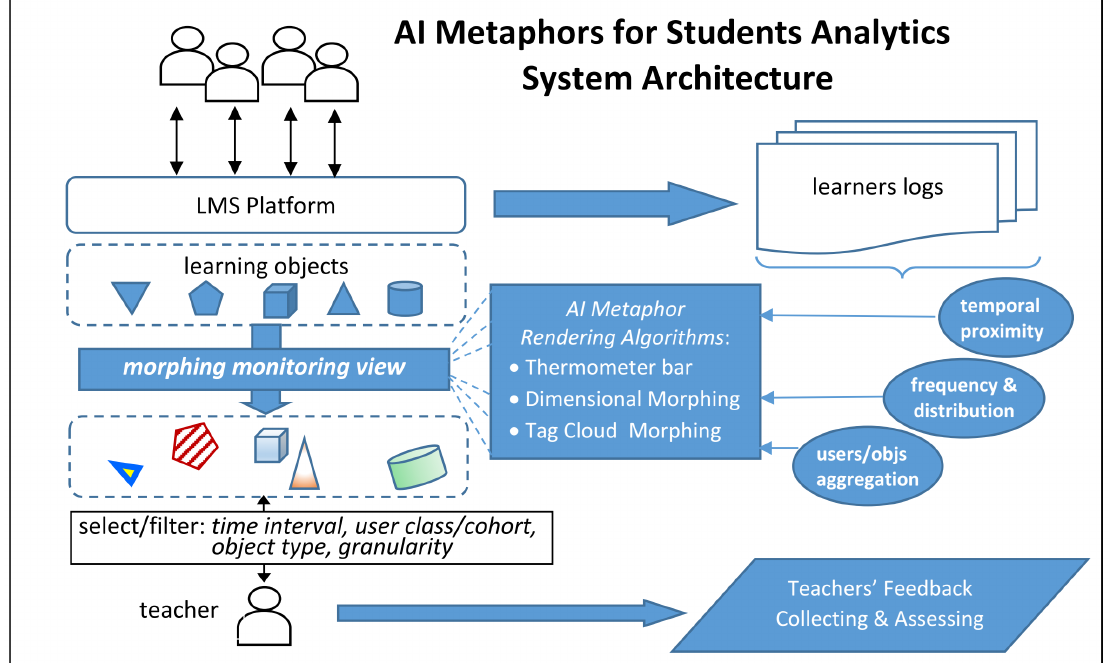
Figure 2. AI–based metaphors for students analytics